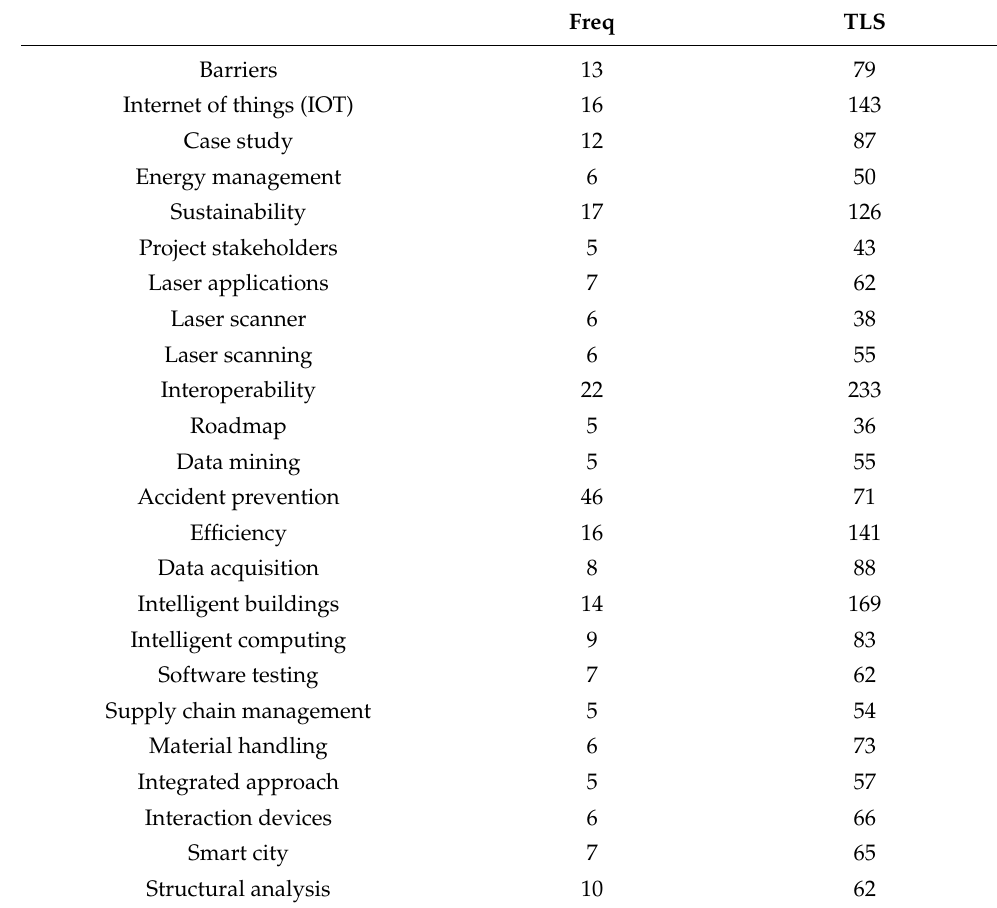
Table 4. Current research